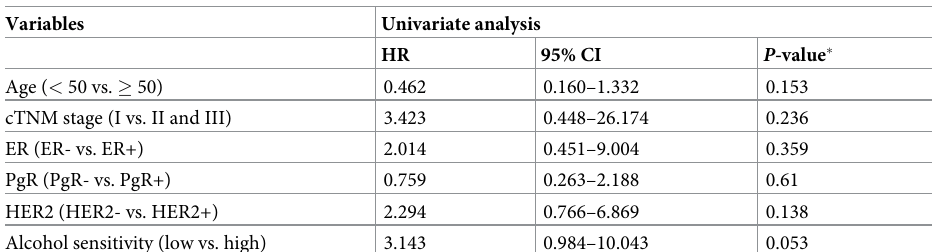
Table 7. Univariate analyses of risk factors for